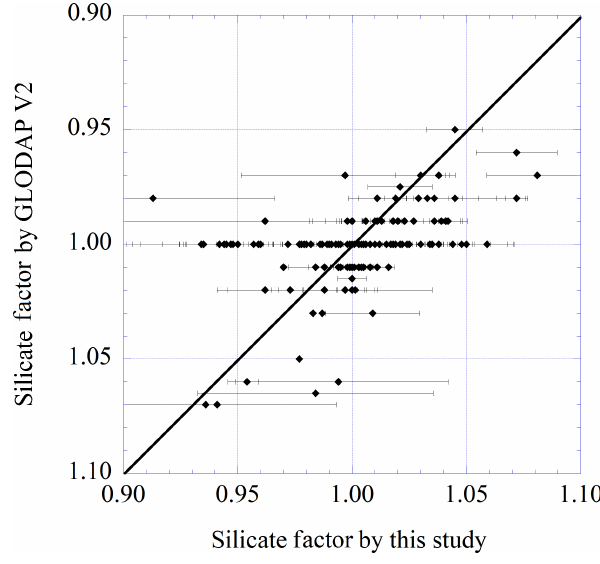
Figure 10. Same as Fig. 7 but for silicate.